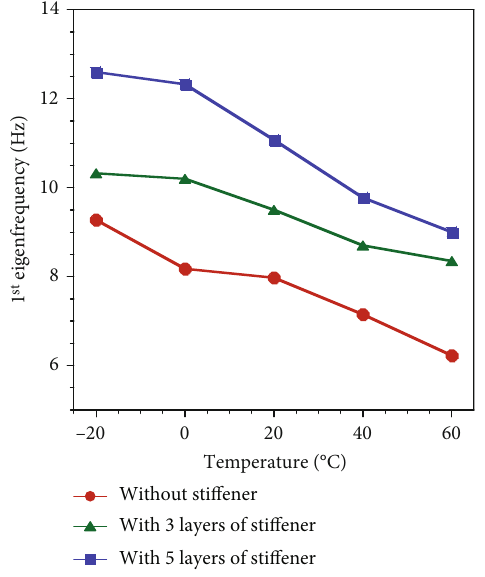
Figure 7: 1 st eigenfrequency of the solar panels under various temperature